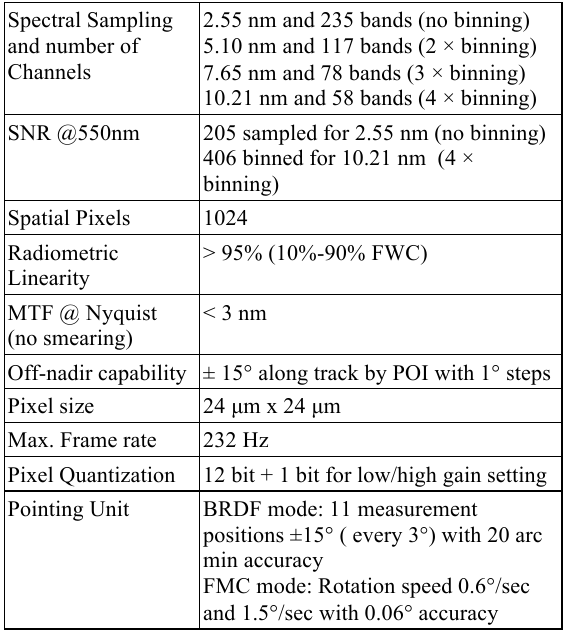
Table 1. Design parameters of the DESIS Instrument DESIS is equipped with a so-called POInting unit (POI) consisting of a rotating mirror in front of the entrance slit. The POI allows to change the DESIS viewing angle in the forward- backward direction between -15˚ and +15˚, in 3˚ steps, with respect to the nominal (nadir) view when operated in static mode (fixed mirror position). This mode will allow to take Bidirectional Reflectance Distribution Function (BRDF) products, which provide different viewing angles of a given target. The POI can also be operated in dynamic mode (moving mirror) with a viewing angle change of up to 1.5˚/second Figure 3. Operation of the POI and fixed mirrors (© DLR-OS) The DESIS instrument is also equipped with an on-board calibration unit comprising different monochromatic and white LEDs in the 400-1000 nm spectral range. The calibration unit location allows the illumination of the full spectrometer FOV using the different LEDs when the POI is in calibration